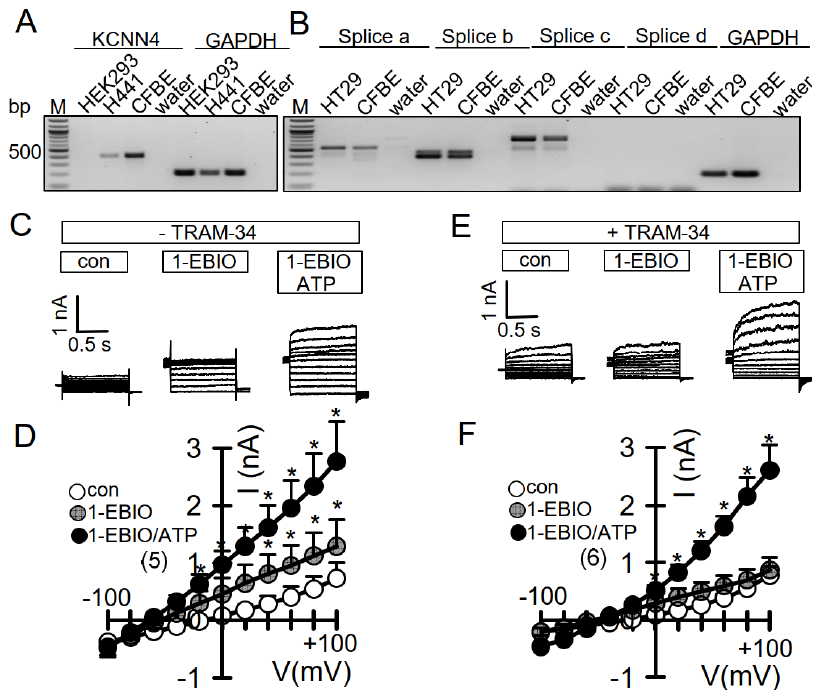
Figure 4. No activation of endogenous TMEM16A by 1-EBIO in CFBE airway epithelial cells. ( A ) RT-PCR analysis indicating expression of Ca 2+ -activated KCNN4 channels in H441 and CFBE airway epithelial cells but not in HEK293 cells. ( B ) RT-PCR analysis indicating expression of the splice variant TMEM16Aa,b,c in HT 29 colonic epithelial and CFBE airway epithelial cells. ( C , D ) Whole cell currents and current/voltage relationships demonstrating current activation and hyperpolarization by 1-EBIO (1 mM) and additional activation by ATP (100 µM). ( E , F ) Activation of whole cell currents and hyperpolarization by 1-EBIO is inhibited by the KCNN4 blocker TRAM-34 (100 nM). Mean ± SEM (n = number of experiments). * Significant activation by 1-EBIO and additional activation by ATP ( p < 0.05; paired t-test).